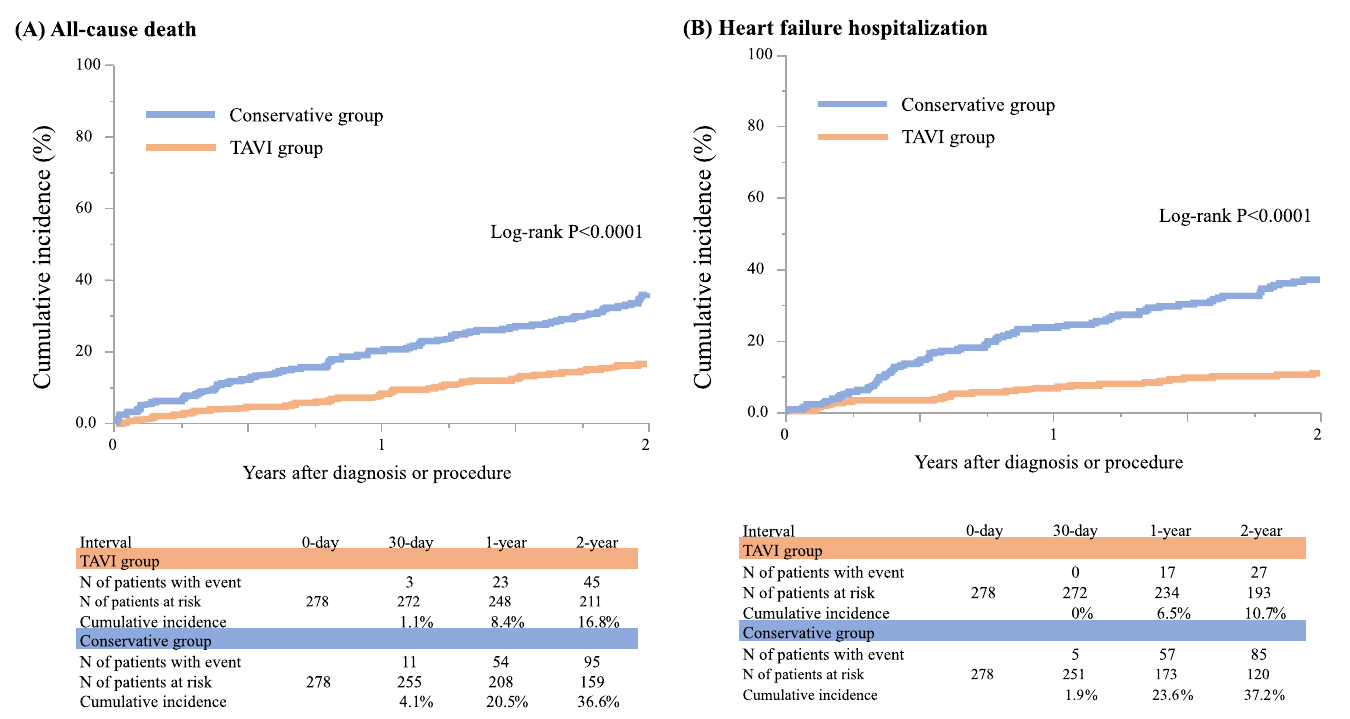
Fig 3. Kaplan-Meier curves for the primary outcome measures comparing between the TAVI and conservative groups in the PS matched cohort. (A) all-cause death. (B) heart failure hospitalization.